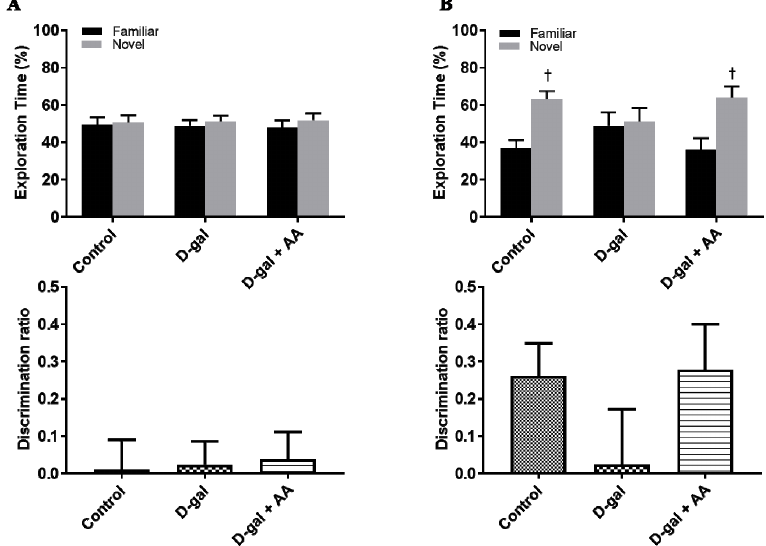
Figure 6. Ascorbic acid (AA) treatment ameliorates object location memory impairment in D-galactose (D-gal)-treated mice. ( A ) During the training phase, mice in all the groups showed no preference for two identical objects. No significant differences were found in the discrimination ratio among these three groups. ( B ) In the test phase, one of the two identical objects was moved into a novel location. Mice in the control and D-gal + AA groups showed a preference for the novel location over the familiar location, whereas mice in the D-gal group did not show preference between the novel location and the familiar location. The discrimination ratio in the D-gal + AA group was significantly higher than that in the D-gal group ( n = 10 per groups; † p < 0.05, indicating a significant difference between familiar and novel location).